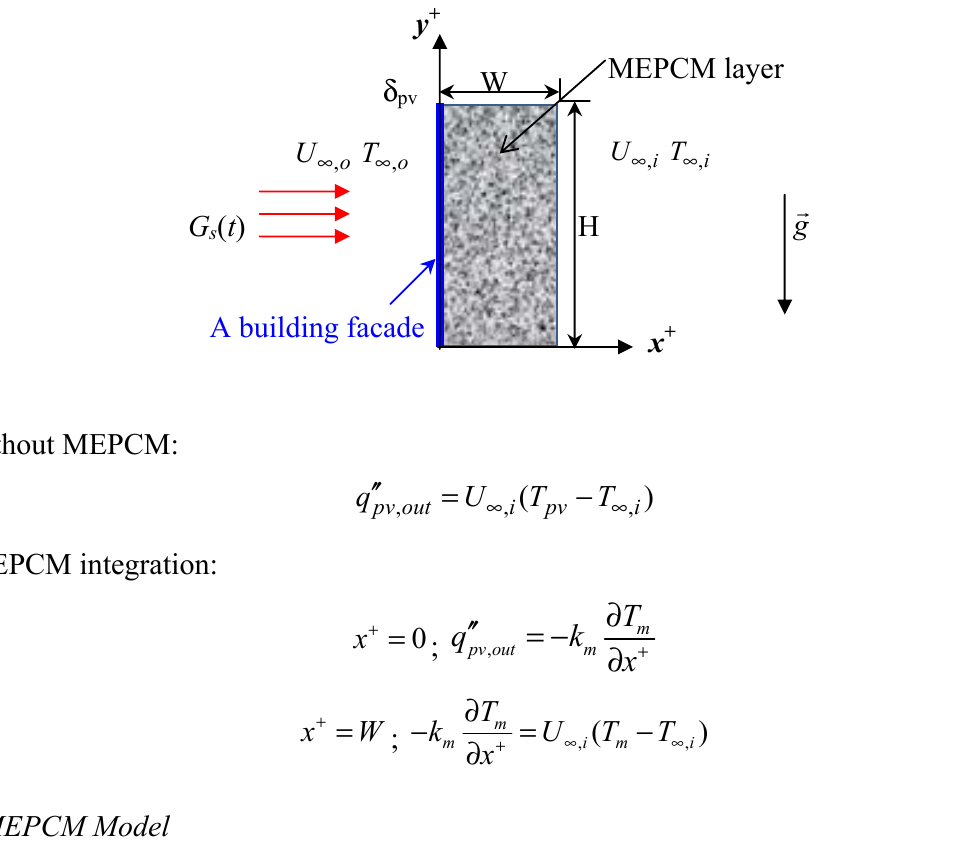
Figure 1. Schematics of heat transfer in an MEPCM